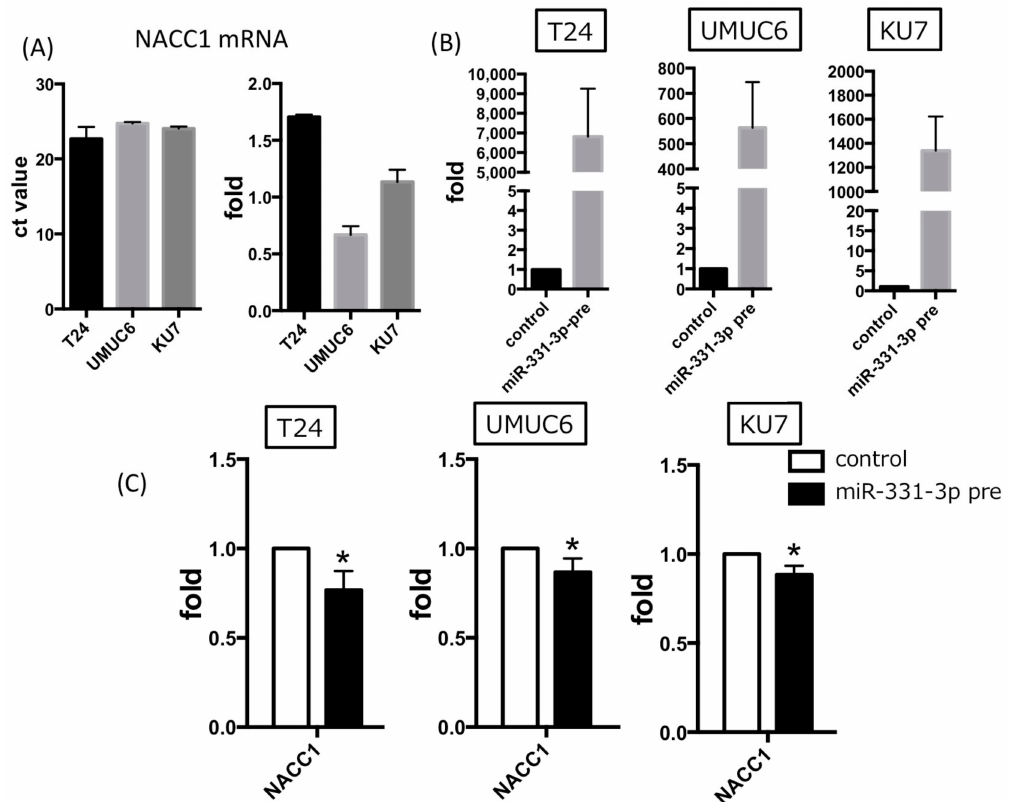
Figure 4. ( A ) mRNA expression of NACC1, which are the putative target molecules of miR-331-3p in T24, UMUC6, and KU7 cells. The left graph shows ct value of three UC cell lines. The right graph shows relative fold value (NACC1/actin); ( B ) The effect of miR-331-3p pre transfection by qPCR; ( C ) NACC1 expression under overexpression of miR-331-3p in three UC cell lines. (* p < 0.05, pre: precursor) miR-331-3p down-regulates NACC1 mRNA expression in T24, UMUC6, and KU7